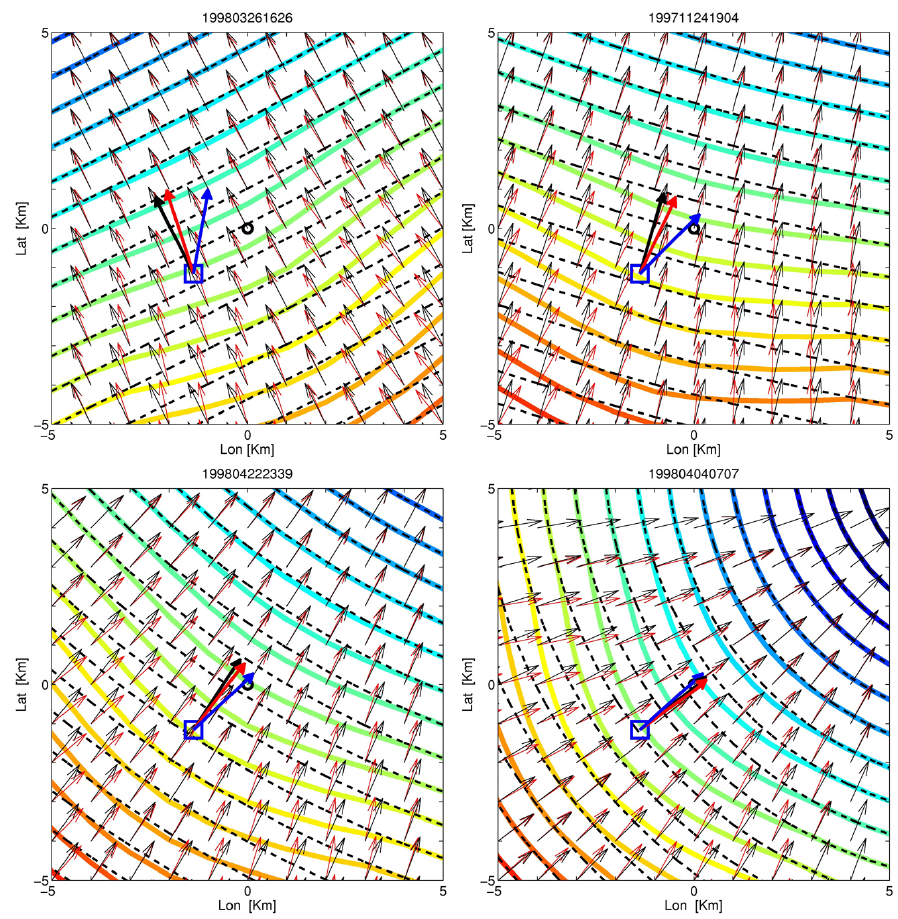
Figure 7. Synthetic wavefronts computed with the slowness anomaly (colored lines) and with a homogeneous slowness model (dashed black lines). Black and red arrows indicate backazimuth values obtained in the case of homogenous and non-homogenous slowness model. Bold bigger arrows show three different backazimuth at the array site: theoretical (black arrow), synthetic (red arrow) and observed (blue arrow). The origin of X and Y axes is set at 40.821, 14.426, the center of Vesuvius crater, also shown by the black circle. The blue square indicates the position of the array. The four panels refers to the first four earthquakes of Table